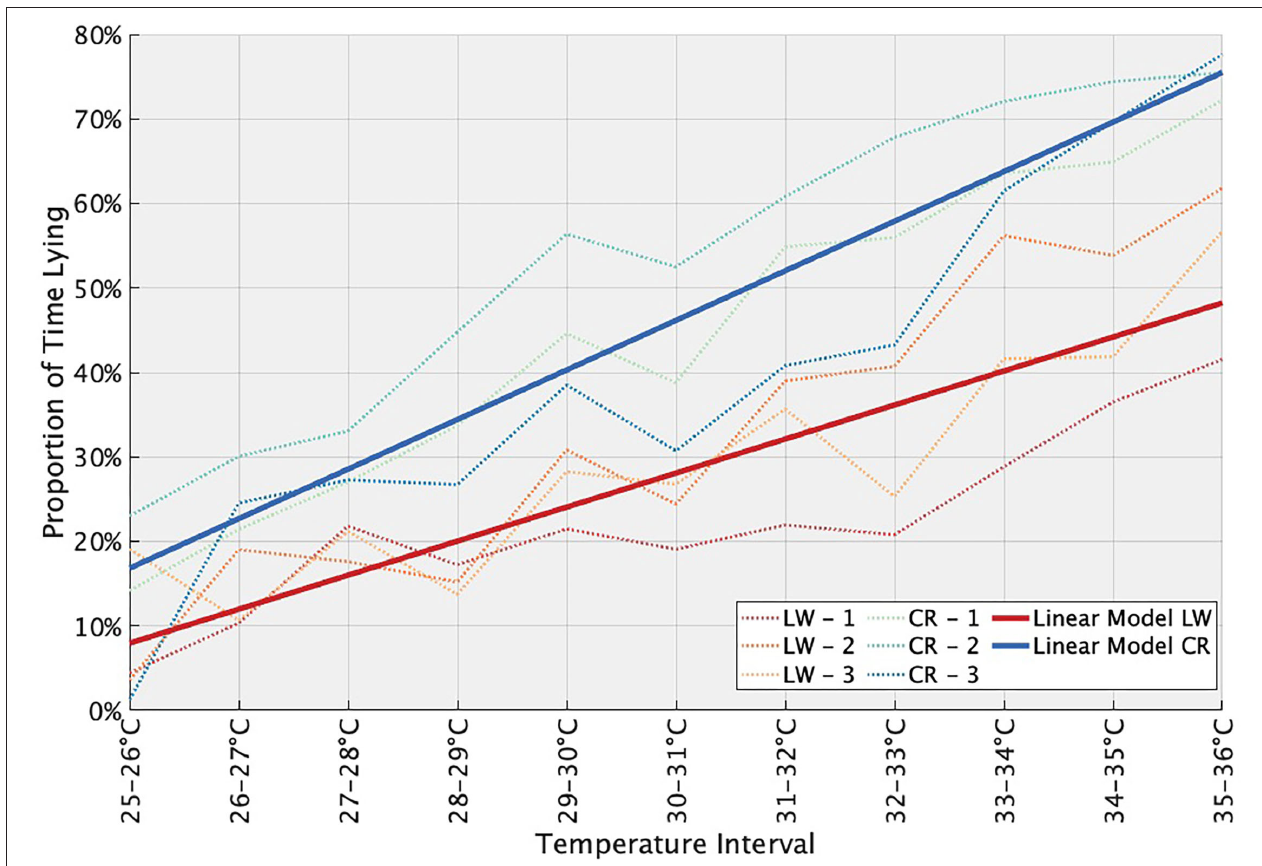
FIGURE 4 | Proportion of time spent lying laterally with temperature. Dotted lines are the estimates of the proportion of time spent lying laterally for each animal (CR in blue and LW in red). Solid lines are linear model estimates for each